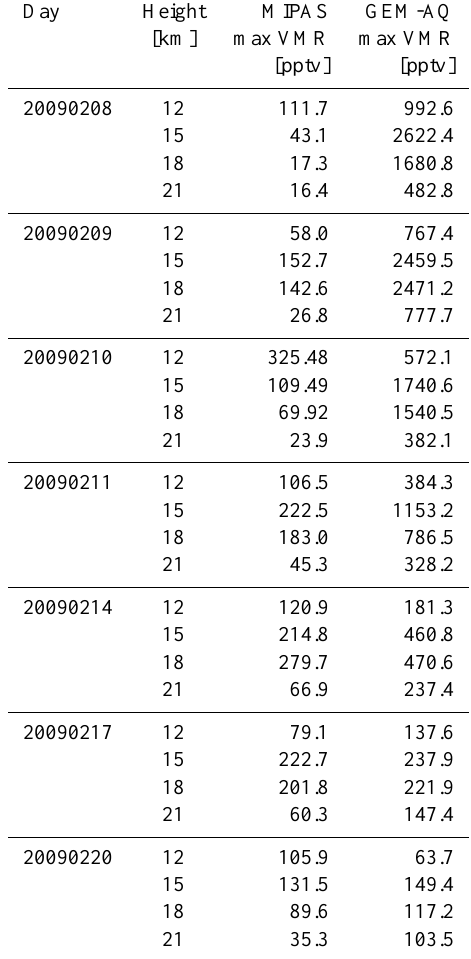
Table 2. Maximum MIPAS and GEM-AQ C 2 H 2 amounts of